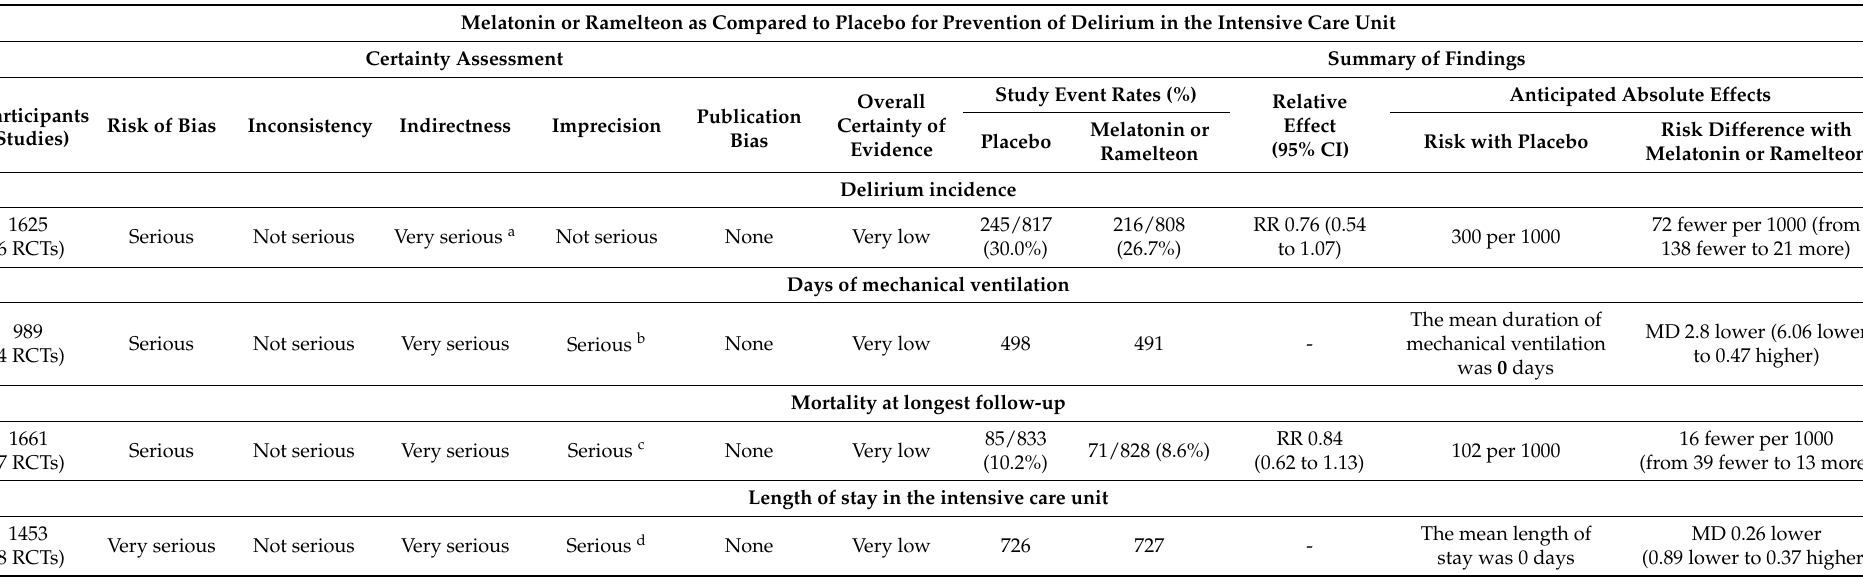
Table 3. Evaluation of quality of evidence according to Grading of Recommendations Assessment, Development and Evaluation (GRADE) working group. Melatonin or Ramelteon as Compared to Placebo for Prevention of Delirium in the Intensive Care